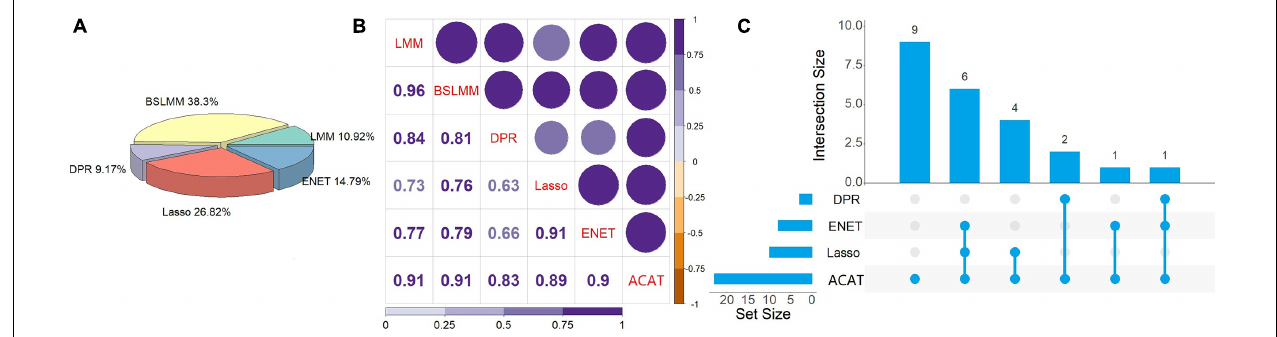
FIGURE 4 | (A) The number of prediction models that have maximum R 2 across all the genes analyzed when predicting expression level with using methylations. (B) Pearson’s correlation of the p -values (in a scale of -log10) obtained via in the Cox linear mixed-effects model with five different prediction models. In the plot the intensity of the color and the size of the circle represent the magnitude of the correlation. (C) UpSet plot to illustrate the intersection of associated genes identified by tests with five prediction models. LMM, Linear mixed model; BSLMM, Bayesian sparse linear mixed model; DPR, Latent Dirichlet Process Regression; ENET, elastic net; ACAT, aggregated Cauchy association